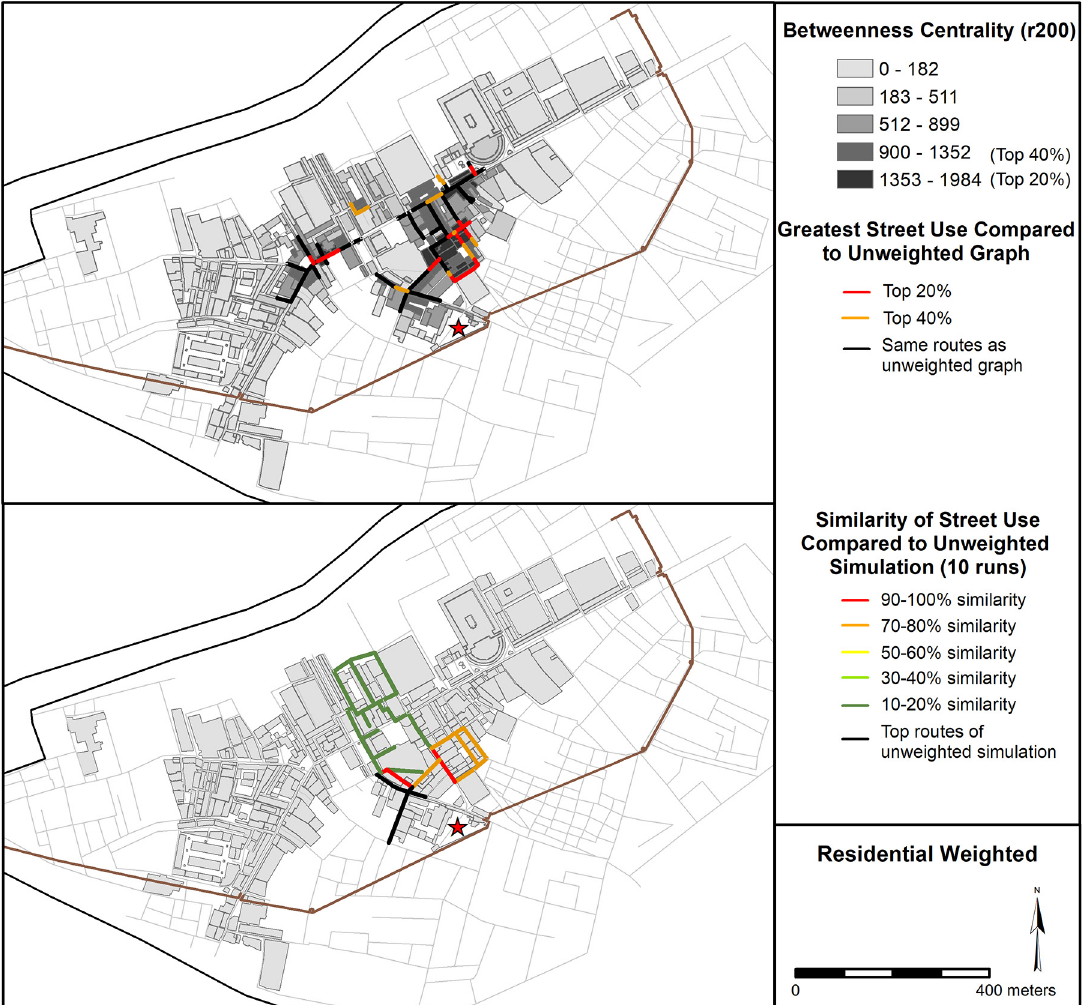
Figure 10. Top: Betweenness centrality graph weighted by residential buildings. Streets displayed in red and orange follow the highest betweenness centrality metrics which are different from the unweighted graph. Bottom: Similarity of street usage by processional runs weighted by residential